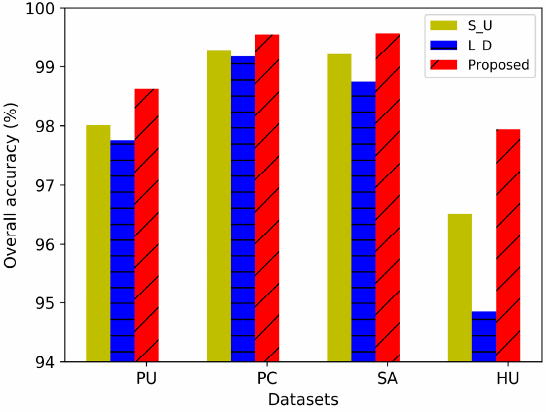
Figure 14. Effective analysis of fusion method.